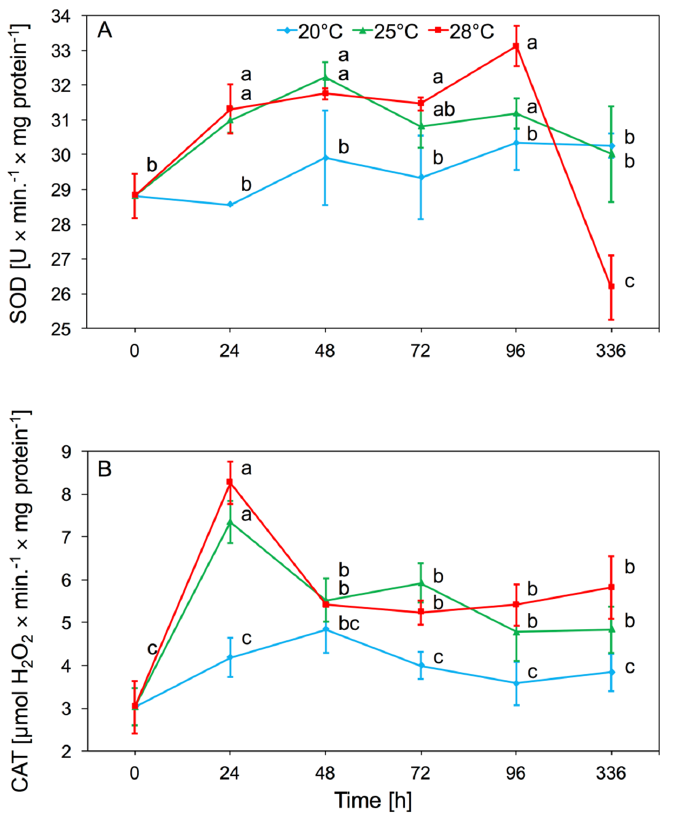
Figure 1. Activity change of superoxide dismutase (SOD) ( A ) and catalase (CAT) ( B ) in the tissues of Aphis pomi at temperature 20, 25, and 28 °C (mean ± SE; control = aphids at 20 °C). Values not followed by the same letter are significantly different at the level of p < 0.05 (Duncan multiple range test).